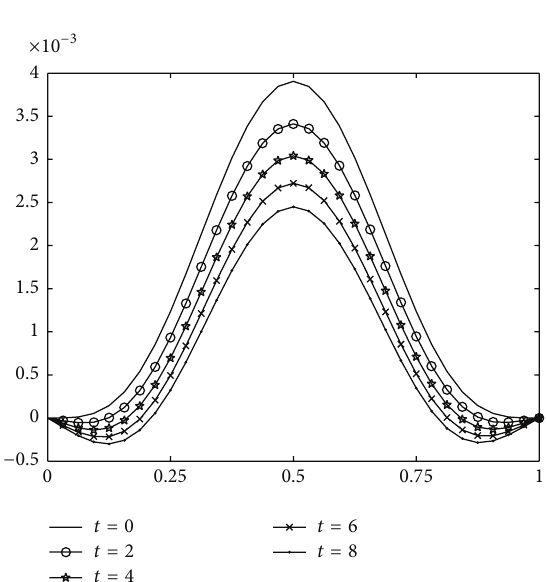
Figure 8: Numerical solutions at different time with ℎ = 1/32 , 𝜏 = 0.1